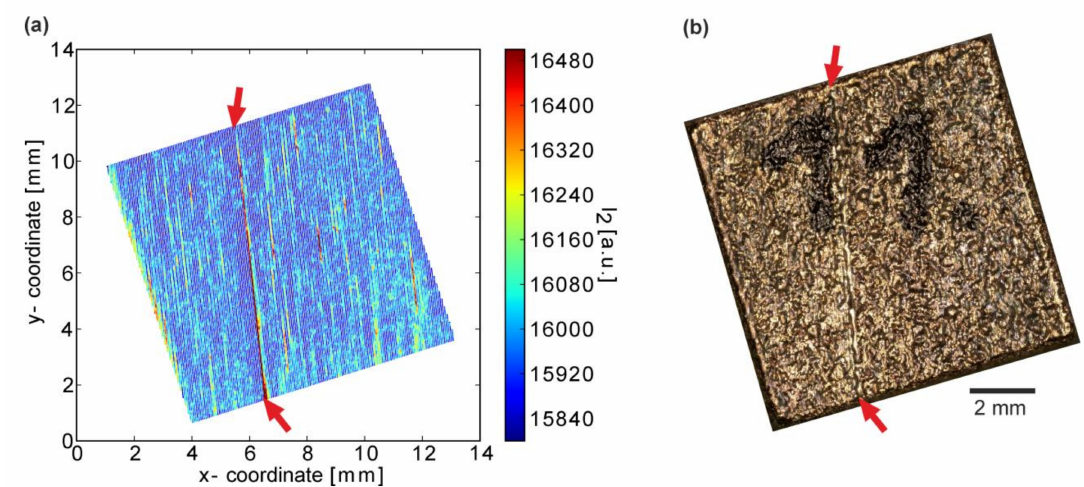
Figure 12. ( a ) Example for MPM data I 2 for the last layer of a specimen (process parameters: t = 50 µ m, P = 400 W, v = 400 mm / s, h = 60 µ m) and ( b ) the corresponding LOM-image. A line-shaped process irregularity is indicated by the red